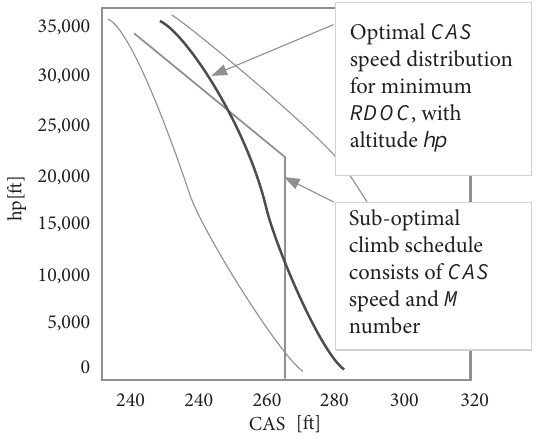
Fig. 2. Adjustment optimal CAS distribution with altitude h with climb schedule: